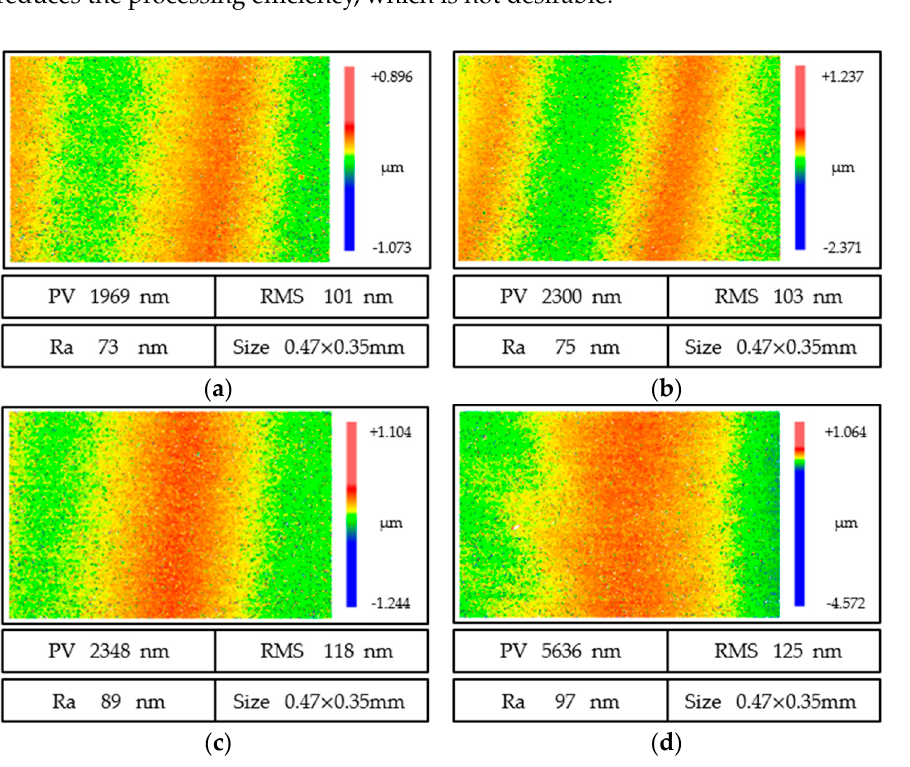
Figure 15. Surface quality evolution of ground fused quartz at different feed rates: ( a ) V = 1.5 mm/min; ( b ) V = 2 mm/min; ( c ) V = 2.5 mm/min; ( d ) V = 3 mm/min.